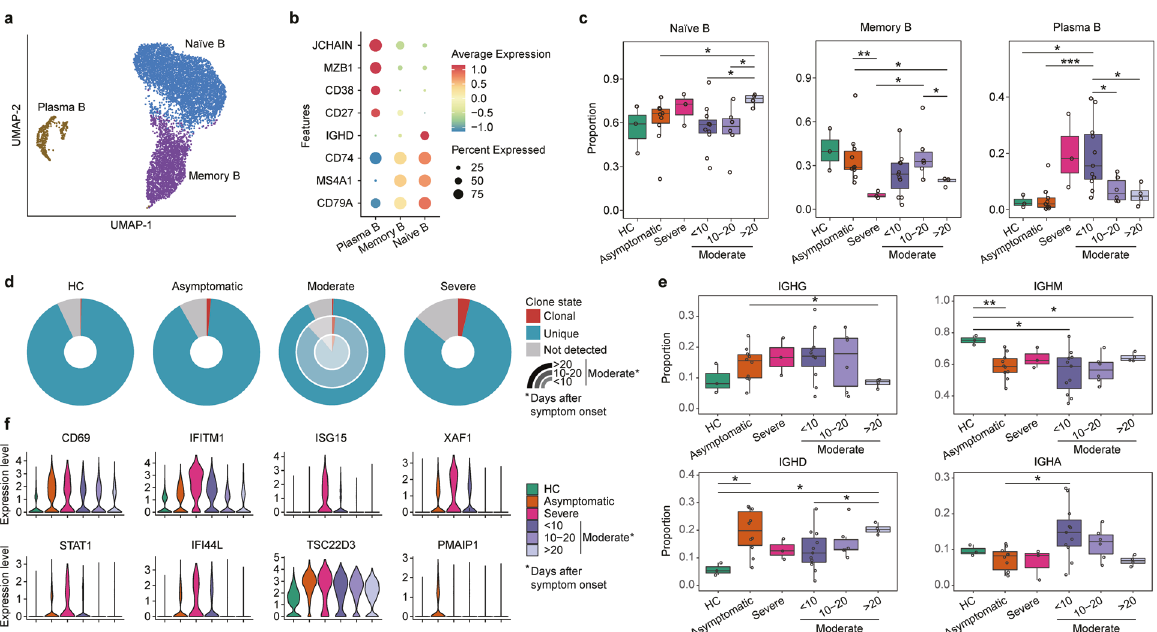
Fig. 6 Subpopulation analysis of B cells. a UMAP projection of B cells. Each dot represents a single cell, colored according to cell type. b Dot plot of canonical cell markers used to annotate clusters in the UMAP plot. c Boxplots showing the differences in percentages of each cell type to the number of B cells comparing different disease conditions to healthy controls (HCs). Boxes are colored according to disease conditions and stages of the moderate condition. The PBMC samples from moderate patients were classi fi ed into 3 stages (<10 days, 10 – 20 days, and >20 days) based on the days after symptom onset. Boxplots indicate the median and interquartile range (IQR); the whiskers represent 1.5 times the IQR. Each circle represents the proportion of each sample. Two-sided unpaired Mann – Whitney U test was used for analysis, and a p value < 0.05 is considered signi fi cant. d The percentage of clonal status in B cells that have BCR, across disease conditions and stages. e Boxplots show the proportion of IgG, IgM, IgD, and IgA, comparing different disease conditions to HCs. Boxes are colored according to disease conditions and stages of the moderate condition. The PBMC samples from moderate patients were classi fi ed into 3 stages (<10 days, 10 – 20 days, and >20 days) based on the days after symptom onset. Boxplots indicate the median and interquartile range (IQR); the whiskers represent 1.5 times the IQR. Each circle represents the proportion of each sample. Two-sided Kruskal – Wallis test was used for analysis, and a p - value < 0.05 is considered signi fi cant. f Violin plots showing the gene expression levels of selected DEGs generated genes in B cells by comparing different conditions. * p < 0.05, ** p < 0.01, *** p < 0.001. No asterisk indicates no statistical signi fi (Supplementary Fig. 8c). Collectively, the different patterns of TCR clonal expansion and diversity and the selective usage of V(D)J genes indicated that different immunodominant epitopes may drive the molecular composition of T cell responses and may be associated with SARS-CoV-2-speci fi c infection.